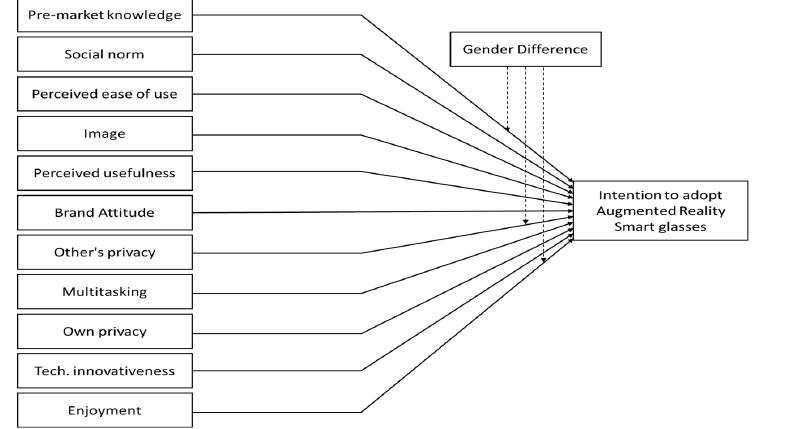
Fig. 7. Research Conceptual